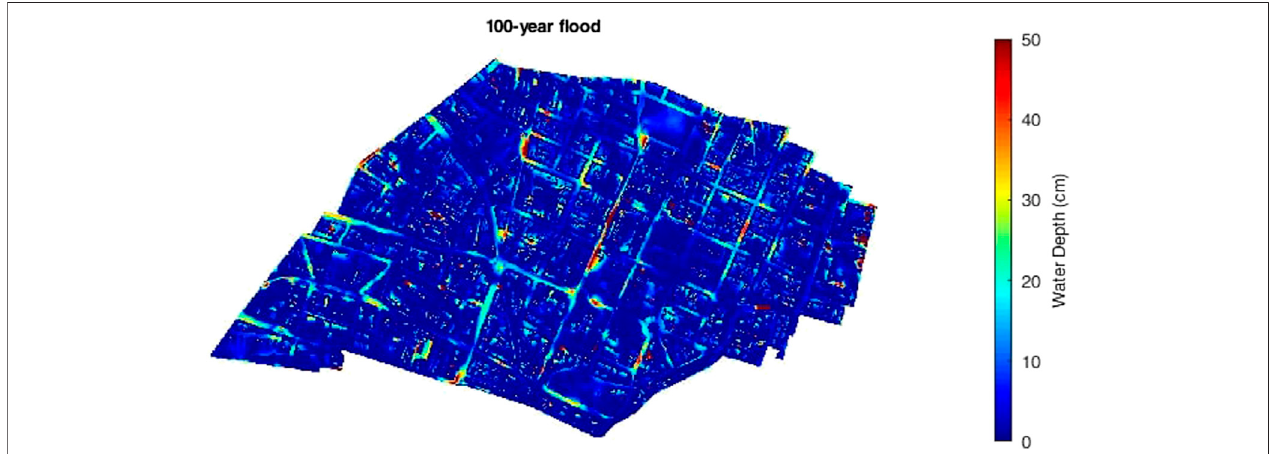
FIGURE 5 | 100-years return period outdoor inundation results for Maxvorstadt (Chen et al., 2018).